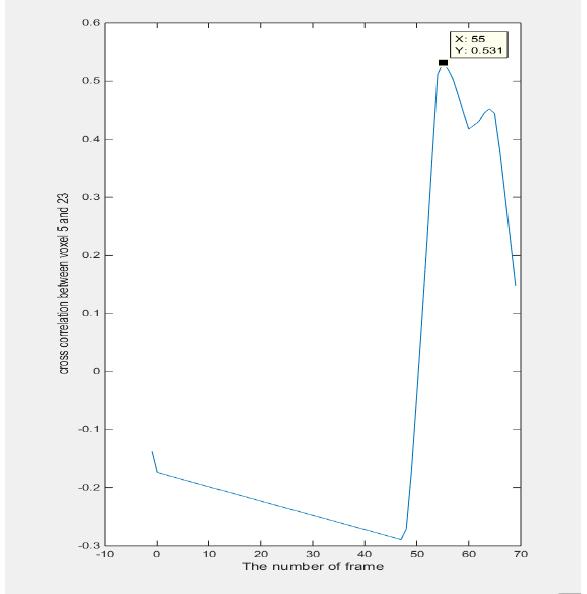
Figure 12. Plots of cross correlation between voxel 8 and 26.